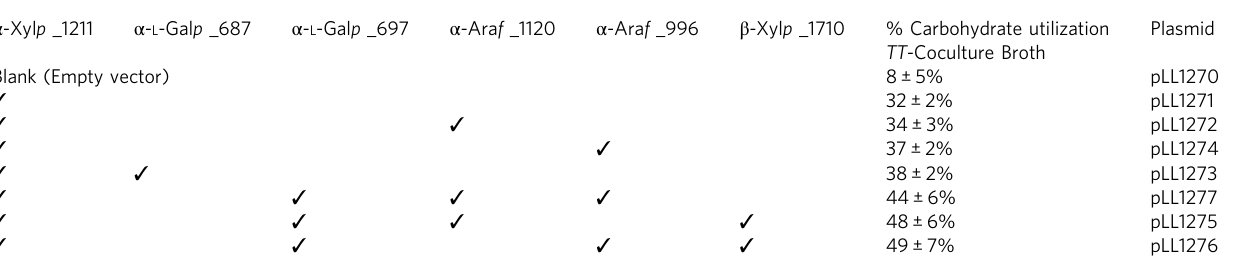
Table 4 Utilization of carbohydrates in TT or TS -Coculture Broths by various T. thermosaccharolticum strains with heterologous expression of identi fi ed enzymes.